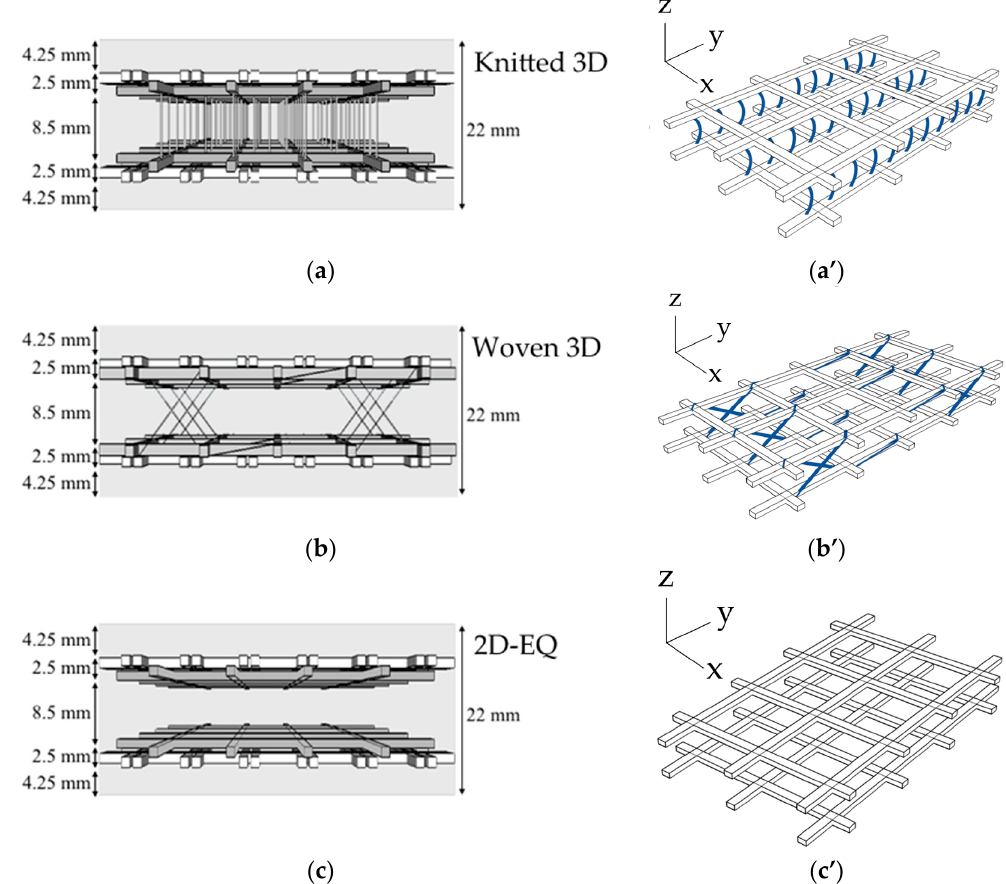
Figure 1. Three considered Textile Reinforced Cement (TRC) layups, from top to bottom: knitted 3D TRC ( a ), woven 3D TRC ( b ) and equivalent 2D TRC ( c ). Left column represents the cross-sectional view of the layups, right column represents the schematics of the transversal connections with axis orientation ( a’ , b’ , and c’ ).